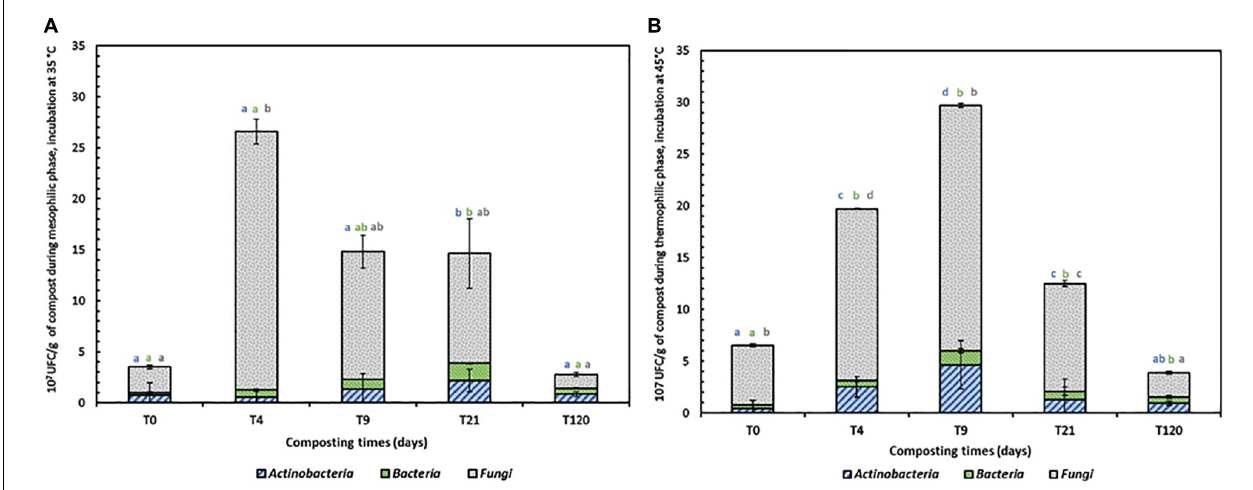
FIGURE 2 | Mesophilic (A) and thermophilic (B) indigenous microbiota (Actinobacteria, Bacteria and fungi (Fungi = Molds and yeasts) groups during co-composting process T 0 = initial mixture, T 4 mixture after 4 days, T 9 mixture after 9 days, T 21 mixture after 21 days and T 120 mixture after 120 days. Bars represent mean values ± SE of 3 replicates that indicate 95% confidence intervals and columns denoted by a different letter differ significantly at p <